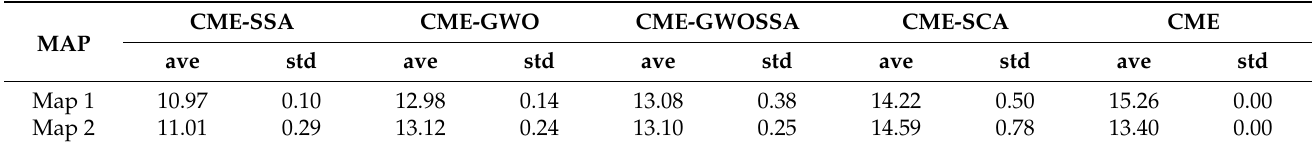
Table 2. Average time taken to explore a map.